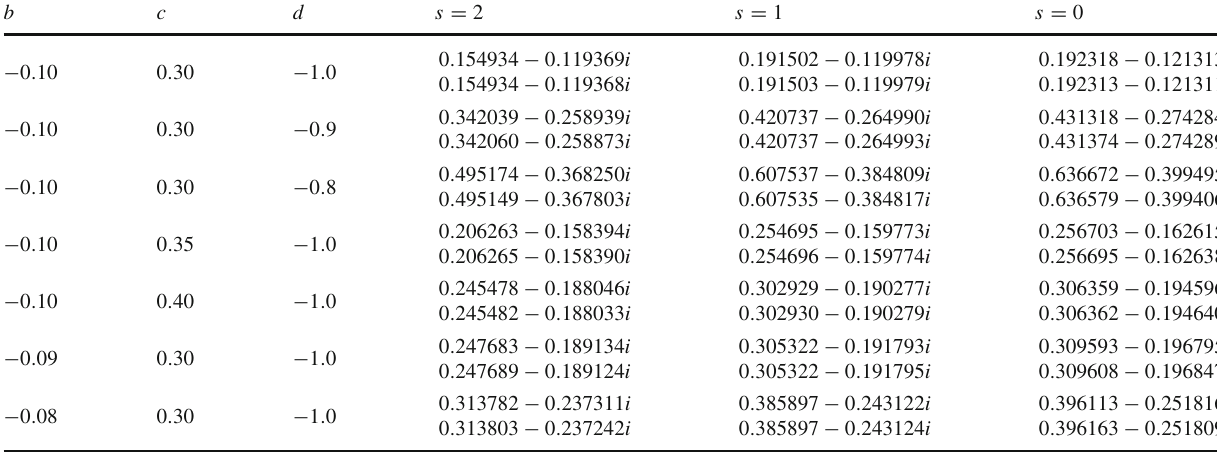
Table 3 The QNMs for n = 1 and (cid:16) = 2, calculated by using the AIM method (first row) and WKB formula (second